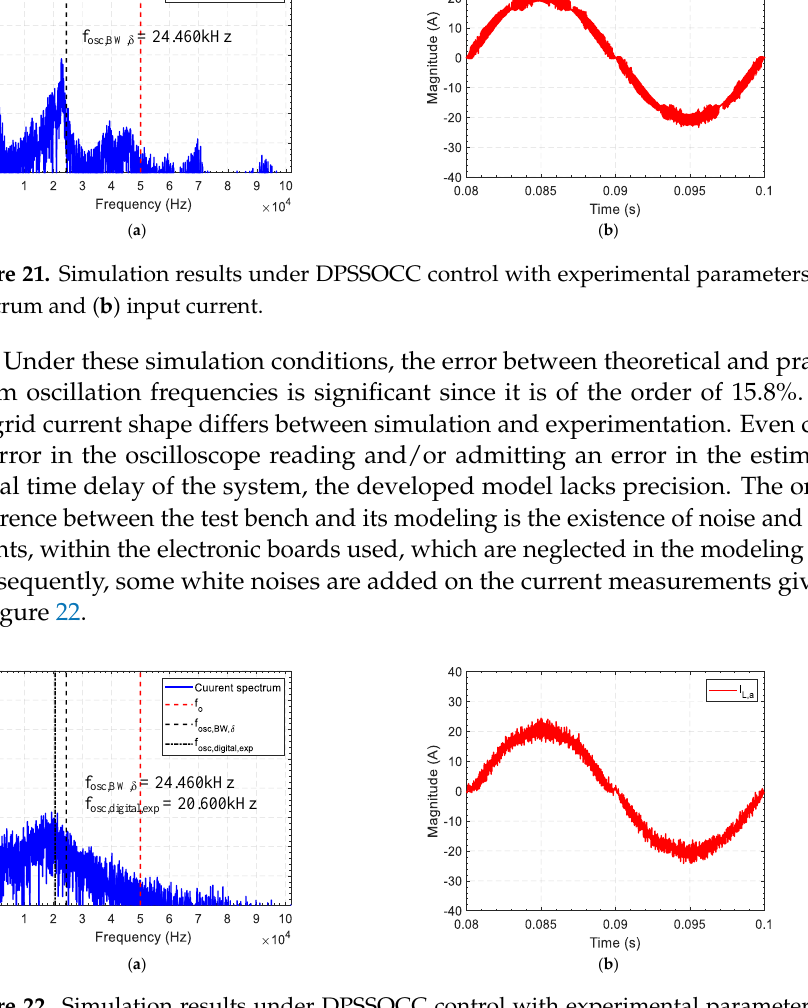
( b ) Figure 23. Simulation results under DPSSOCC control with DC/DC converter: ( a ) current spectrum and ( b ) input current The results with a resistive load and with the DC/DC converter are extremely simi- lar. Therefore, the use of a resistive load to replace the power converter is sufficient to validate the regulation principle applied to the complete energy conversion chain of a three-phase welding power source. Commented [M19]: Please confirm: in the figure, is the number 20600 or 20.600? - if it’s 20600, it can remain unchanged - if it’s 20.600, please modify to 20.600 Commented [QB20]: Modified